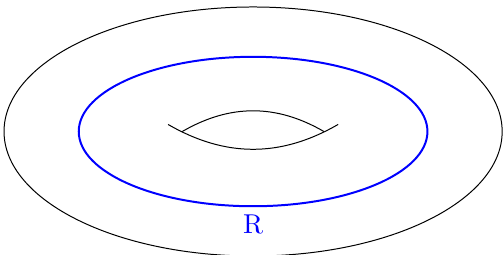
Figure 9 . The state | R CS i is defined by the path integral on a solid torus with a Wilson loop operator